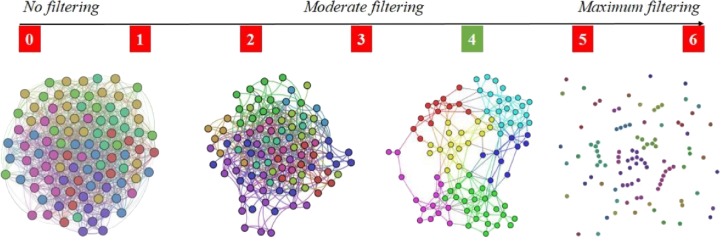
Apnea Patients Network (APN) edge filtering, by considering different definitions for fRFC = 1, when we adopt the x-out-of-6 criteria (x = 1, 2, 3, 4, 5, and 6).The visual result indicate x = 4 as the best solution, because the edge density is convenient for rendering topological clusters with energy model layouts. Other values for x will generate too dense or too sparse networks.